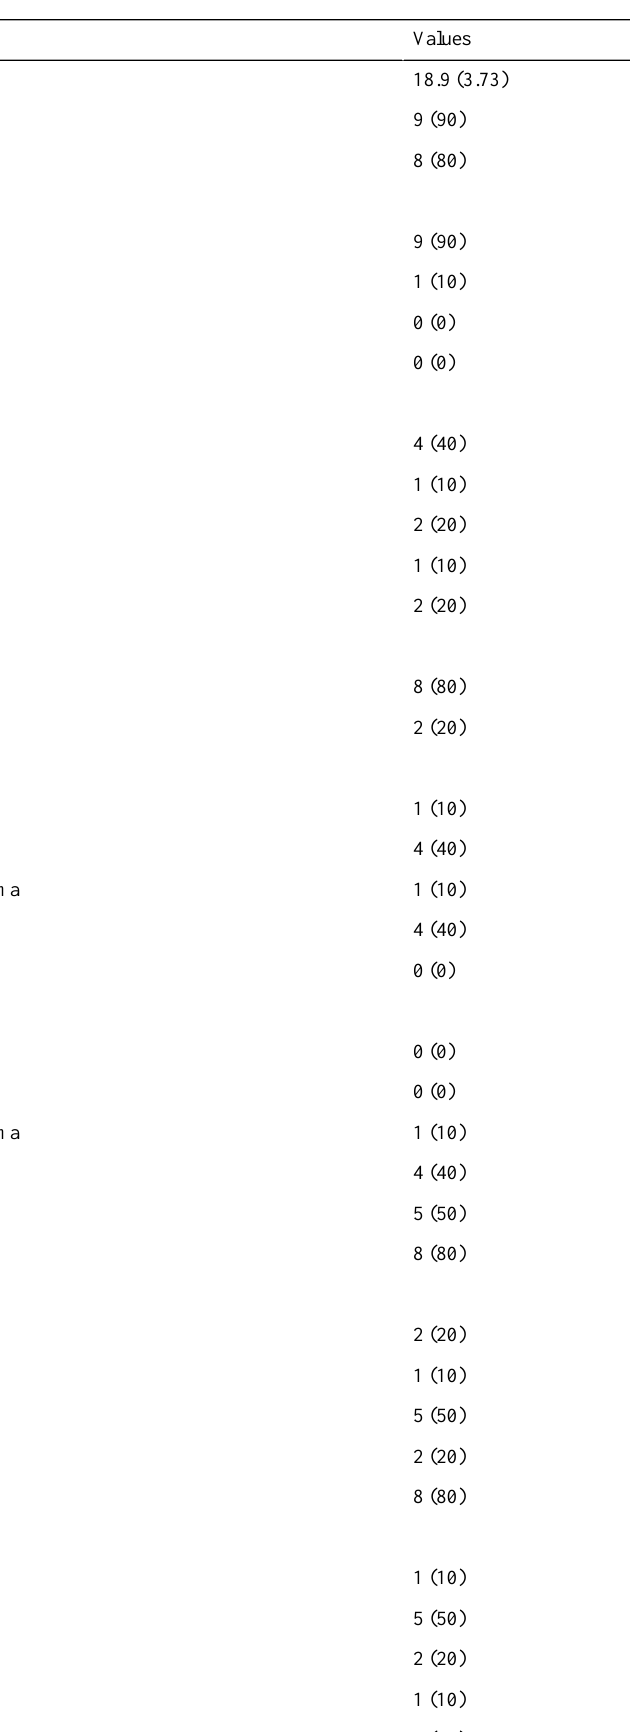
Table 1. Demographical data of the youths in this study